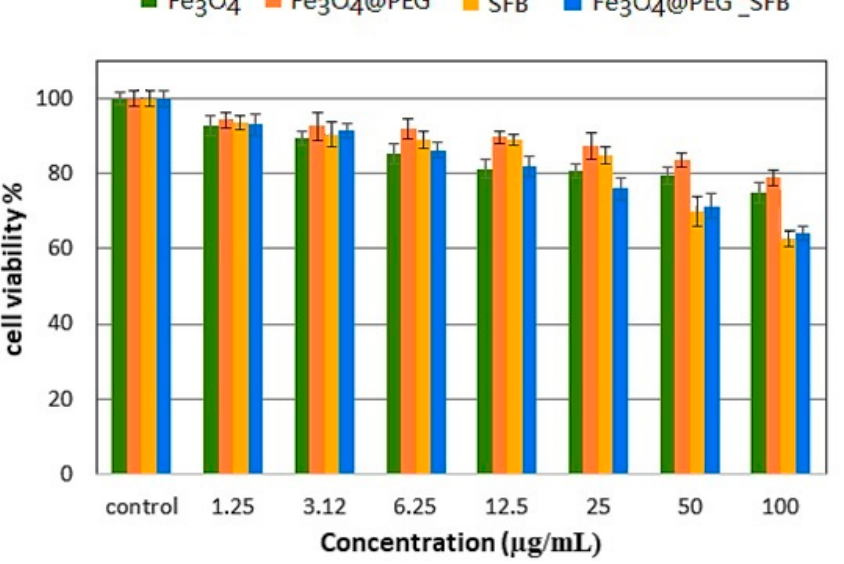
Figure 8. Cell viability of Fe 3 O 4 , free SFB, Fe 3 O 4 @PEG, Fe 3 O 4 @PEG_SFB against healthy 3T3 cells at 72 h. Note: Results were calculated as mean ± standard deviation for N = 3 independent